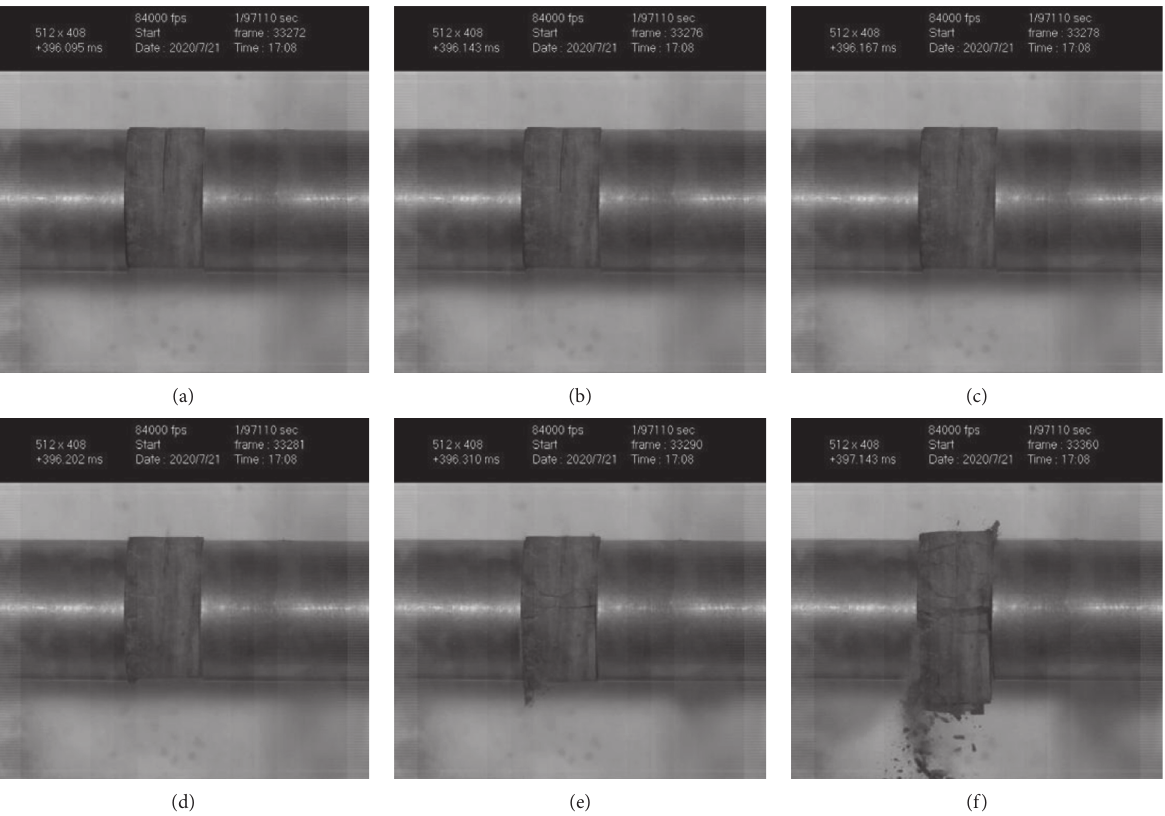
Figure 12: Failure of cracked specimen. (a) 0 us, (b) 48us, (c) 72us, (d) 107us, (e) 215us, and (f) 1048us.